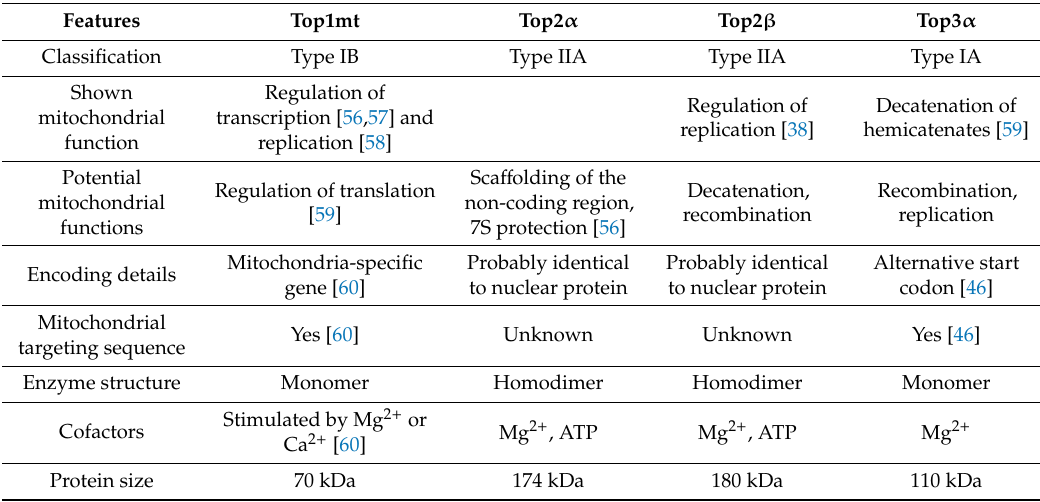
Table 1. Features of the four topoisomerases in mammalian